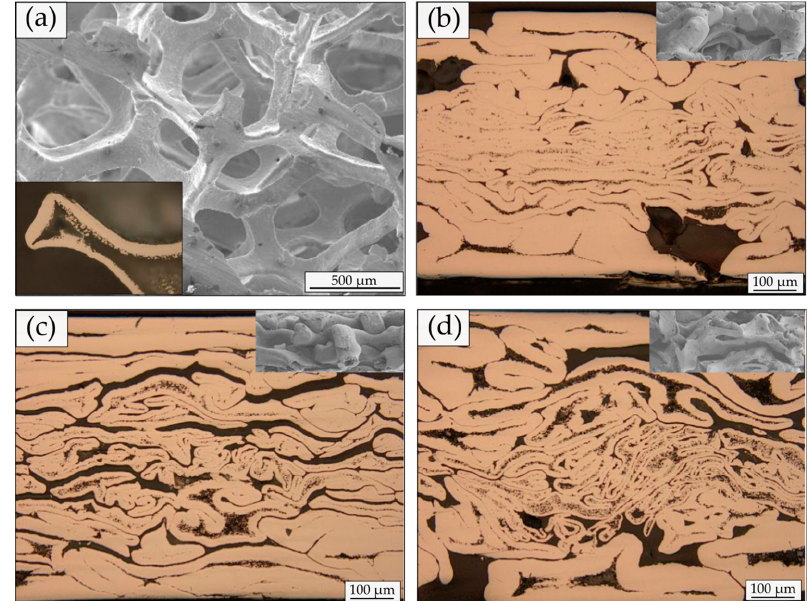
Figure 12. Optical photographs of the ( a ) as-received open-cell Ni foam, ( b ) ESR Ni, ( c ) HRDSR Ni (SR of two) and ( d ) HRDSR Ni (SR of three) samples. The inset in (a) shows the cross-section of the cell ligament. The insets in (b–d) show the SEM pictures taken on the lateral side of the rolled samples [49]. Reproduced with permission from Jeong et al., Mater. Sci. Eng. A ; published by Elsevier, 2019.